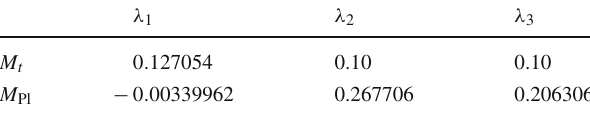
Table 1 A set of values of all quartic coupling constants at M t and M Pl for M